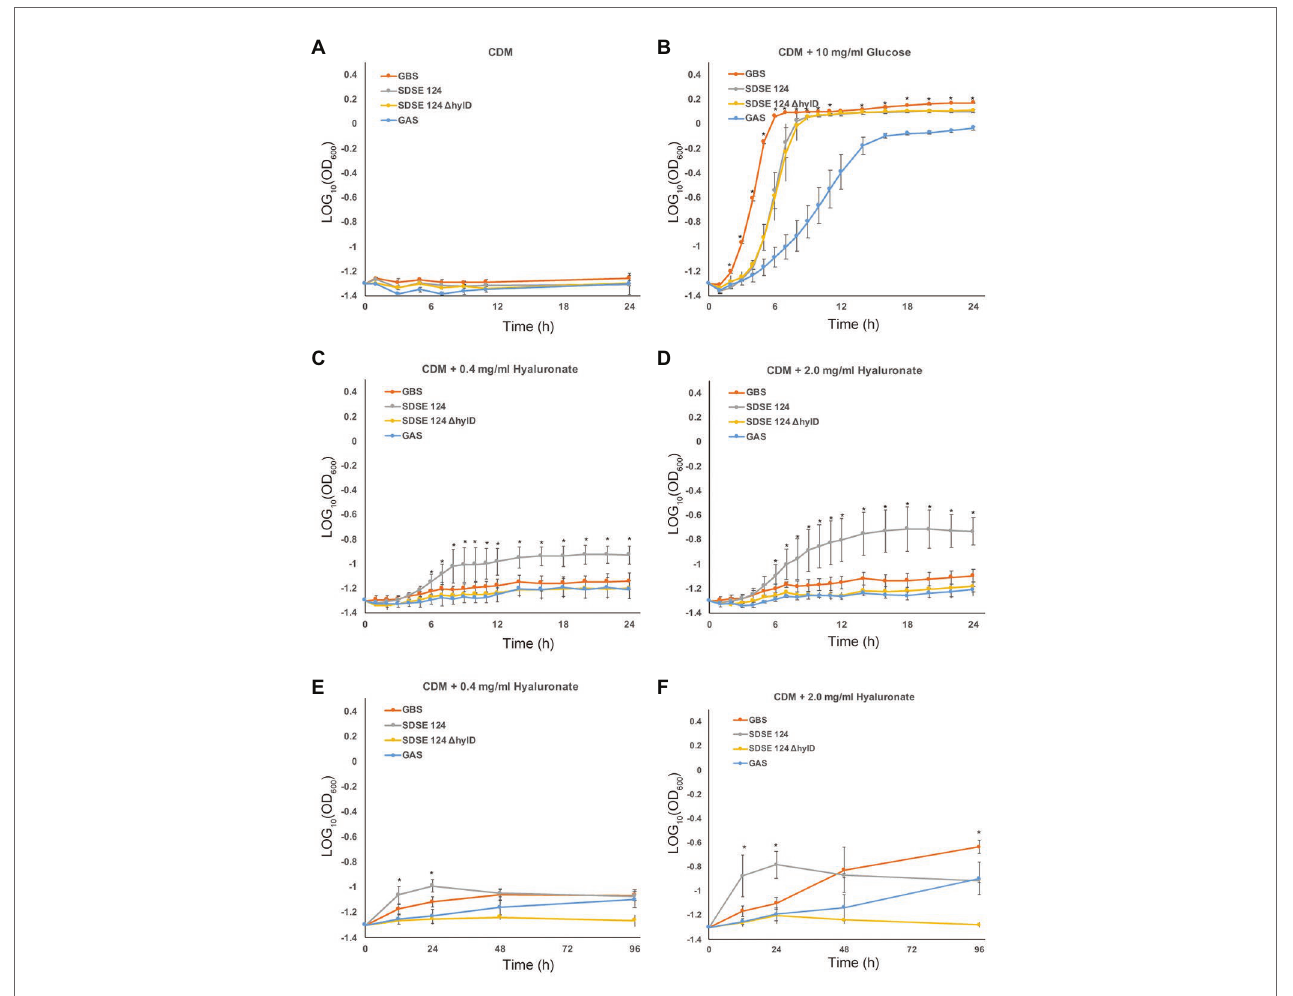
FIGURE 3 | Growth curves in minimal medium. Bacterial growth was assessed during a 24 h of incubation in chemically defined medium (CDM) containing (A) no carbohydrate, (B) 10 mg/ml glucose, (C) 0.4 mg/ml HA, or (D) 2.0 mg/ml HA. Bacterial growth was assessed during a 96 h incubation in CDM containing (E) 0.4 mg/ml HA or (F) 2.0 mg/ml HA. Bacterial strains GAS-476, GBS-COH1, SDSE-124, and SDSE-124 Δ hylD were cultivated in BHI medium overnight, collected by centrifugation, and resuspended in each medium as indicated. The average and standard deviation at each point were calculated from three separate experiments performed in triplicate. Analysis of variance and Bonferroni post hoc test were conducted to assess overall difference in OD 600 at each time point; * p <